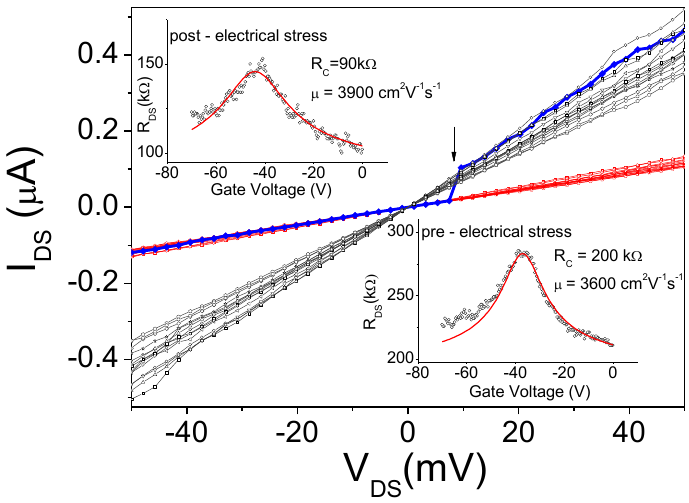
Figure 2. Output characteristics ( I DS vs. V DS ) and transfer characteristics ( R DS vs. V Gate in the insets) measured before and after the stabilization of the device due to electrical stress. Black arrow indicates the switch from higher to lower total resistance. Continuous (red) lines in the insets represent the numerical simulations obtained from the model of [32]. The contact resistance R contact is abbreviated as R C in the figures.